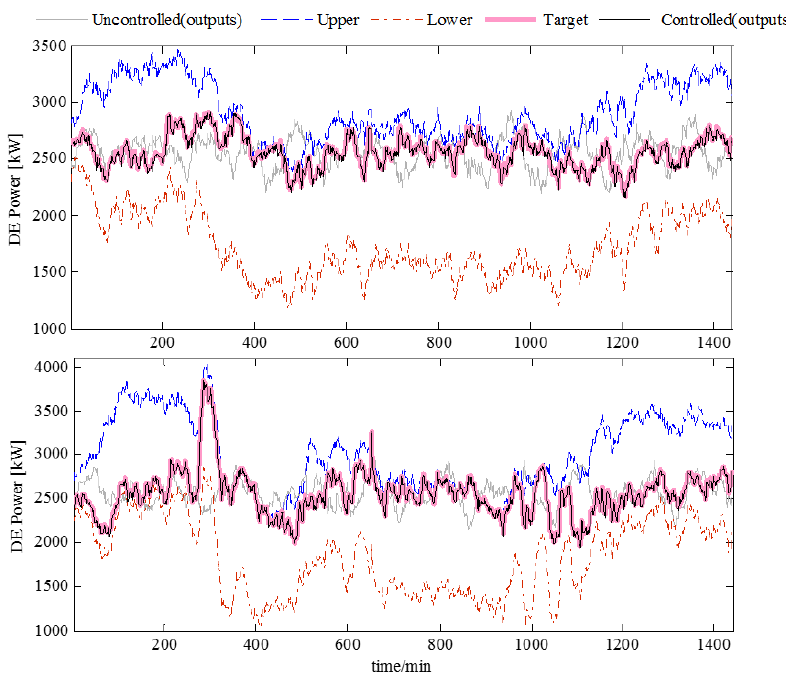
Figure 15. Response of electrolyzers in the 50% ( top panel ) and 100% ( bottom panel ) controlled cases.